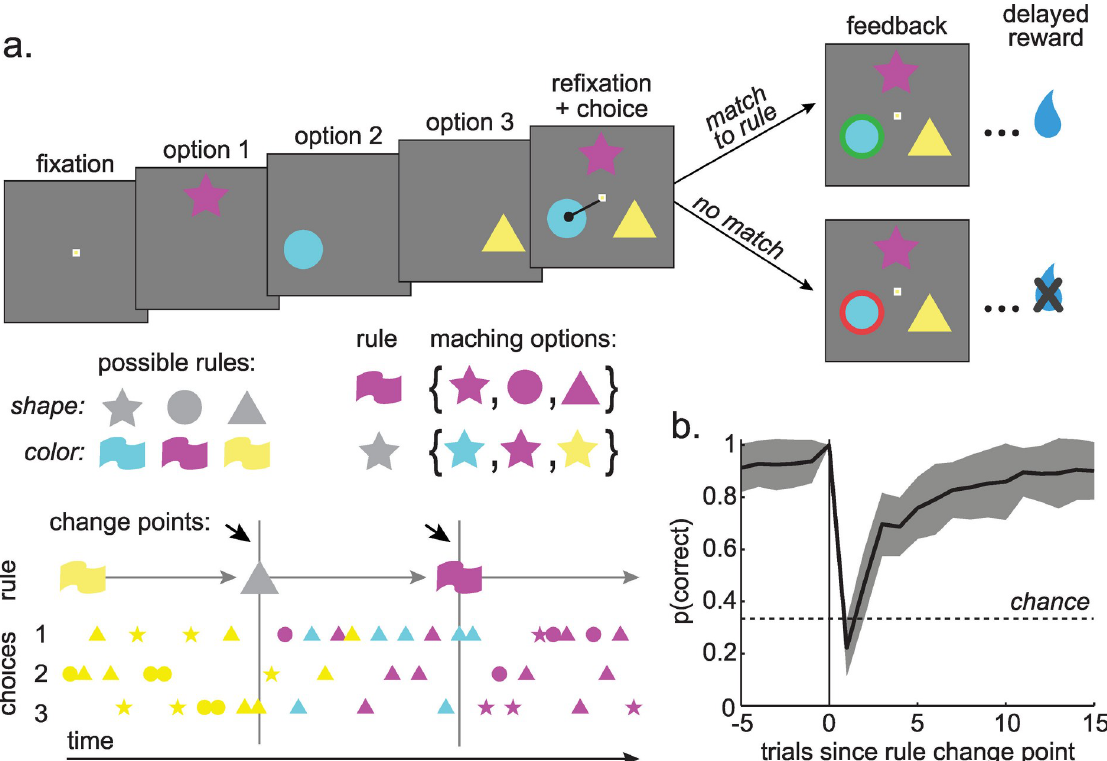
Fig 1. Task design and baseline behavior. A) The CCST task. Three options, which differed in both shape and color were sequentially presented. Choosing an option that matched the rewarded rule produced a green outline around the chosen option and a reward. Choosing either of the other two options produced a red outline and no reward. Middle row, left: Rules could be any of the three shapes or any of the three colors. Right: The options that matched a rule were the set of stimuli that shared the rule’s feature. Bottom: After the monkeys achieved 15 correct choices, the rewarded rule changed, which forced the monkeys to search for the new rule. B) Percent correct as a function of trials before and after rule changes. The 0 th trial is the last trial before the rule changed. Gray shading +/-